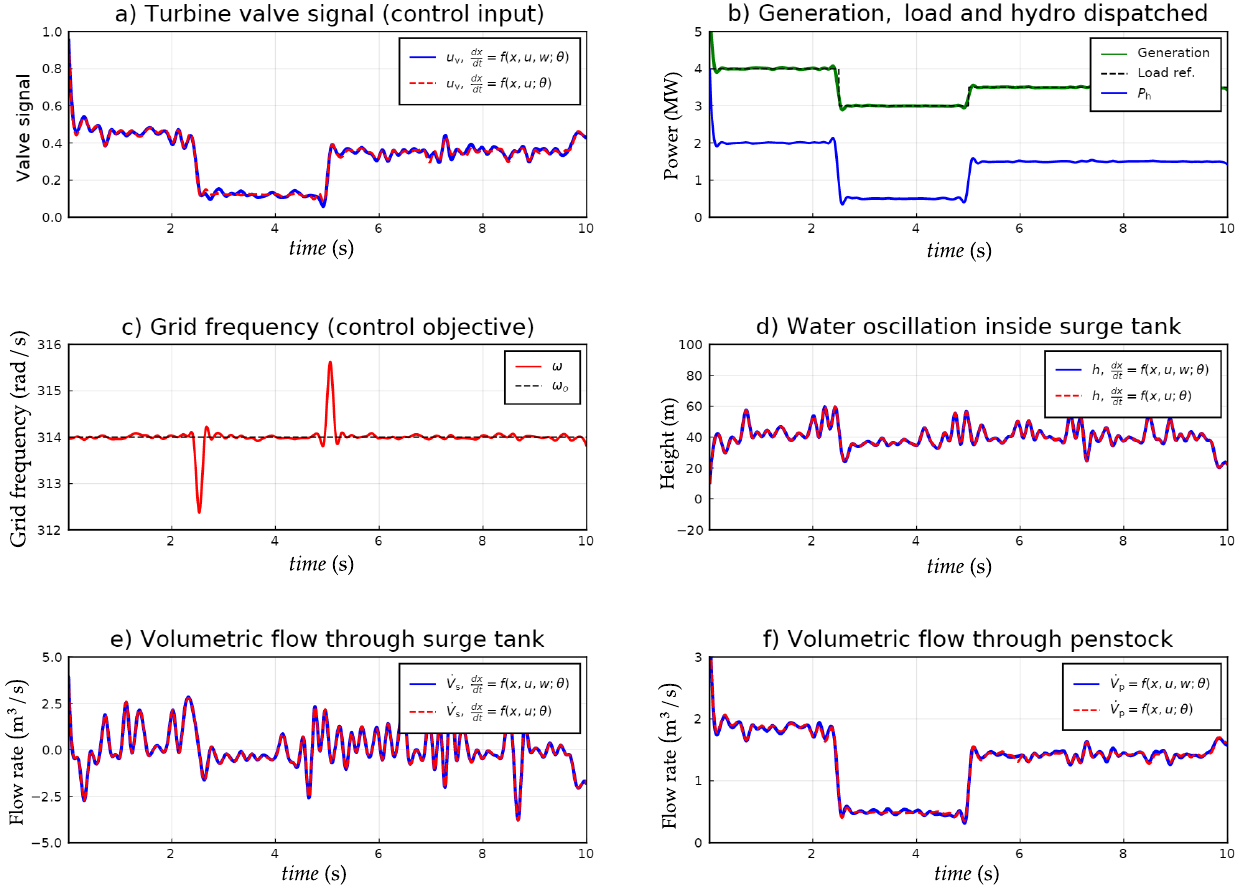
Figure 11. Setpoint tracking of scheduled load with process disturbance and measurement noise, and step change in solar and wind